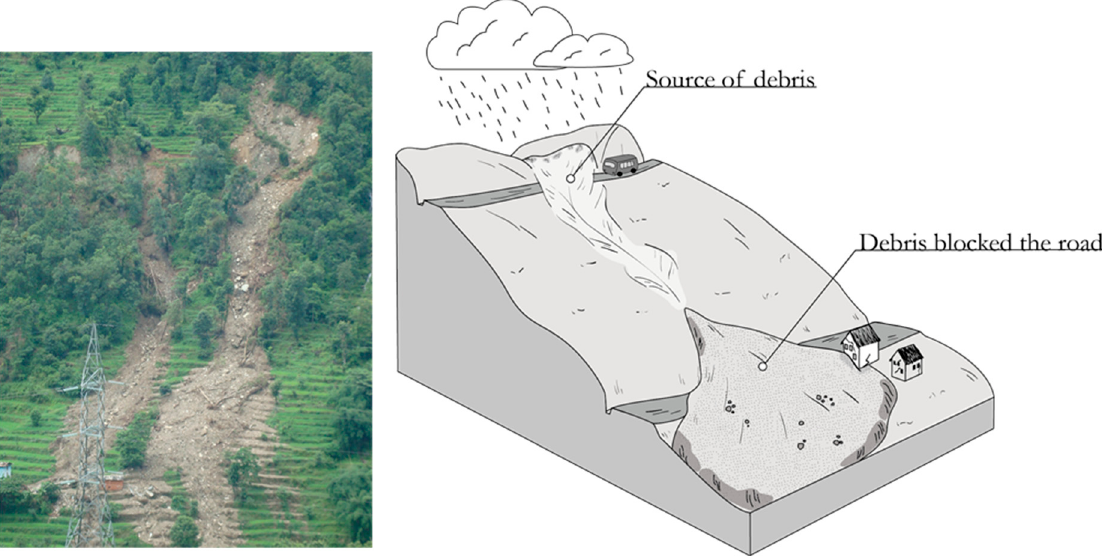
Figure 6. ( Left ) View of slope failure due to intense rainfall; ( Right ) schematic illustration of debris flow [57] .